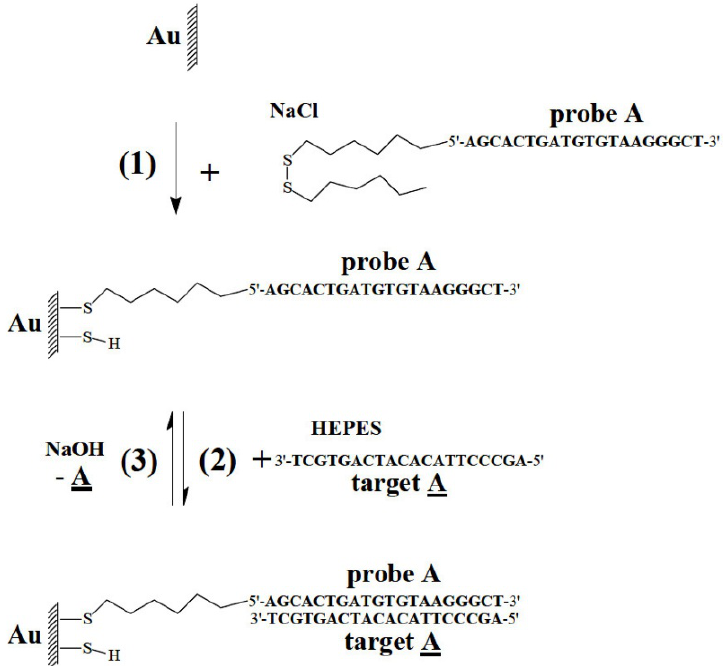
Figure 3. DNA-disulfide biosensor: immobilization of DNA-disulfide probe A ( 1 ), hybridization of a complementary DNA target A ( 2 ) and dehybridization of the DNA target A ( 3